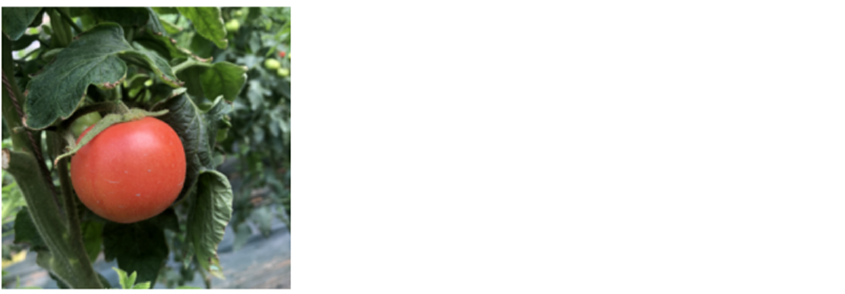
Figure 15. Generated sentence (predicted caption) and correct answer sentence (real caption) for the image of a normal tomato.